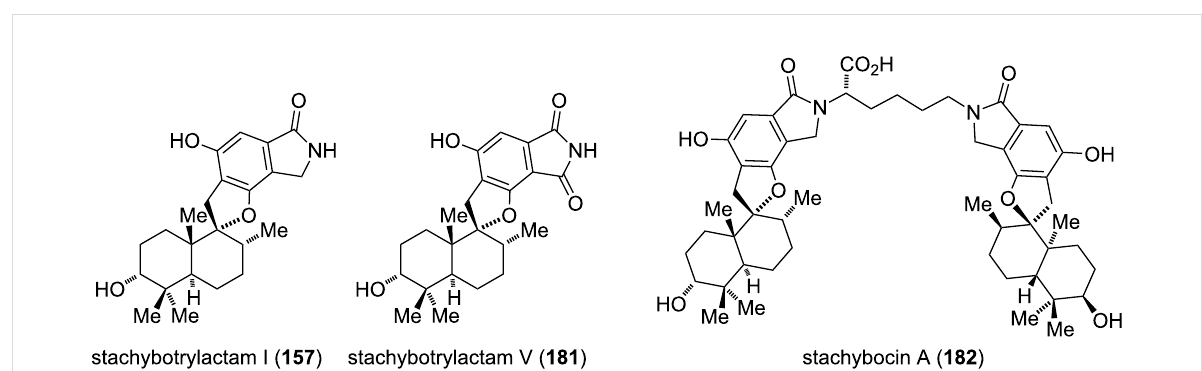
Scheme 22: Synthesis of stachyflin ( 156 ) by Katoh [144].